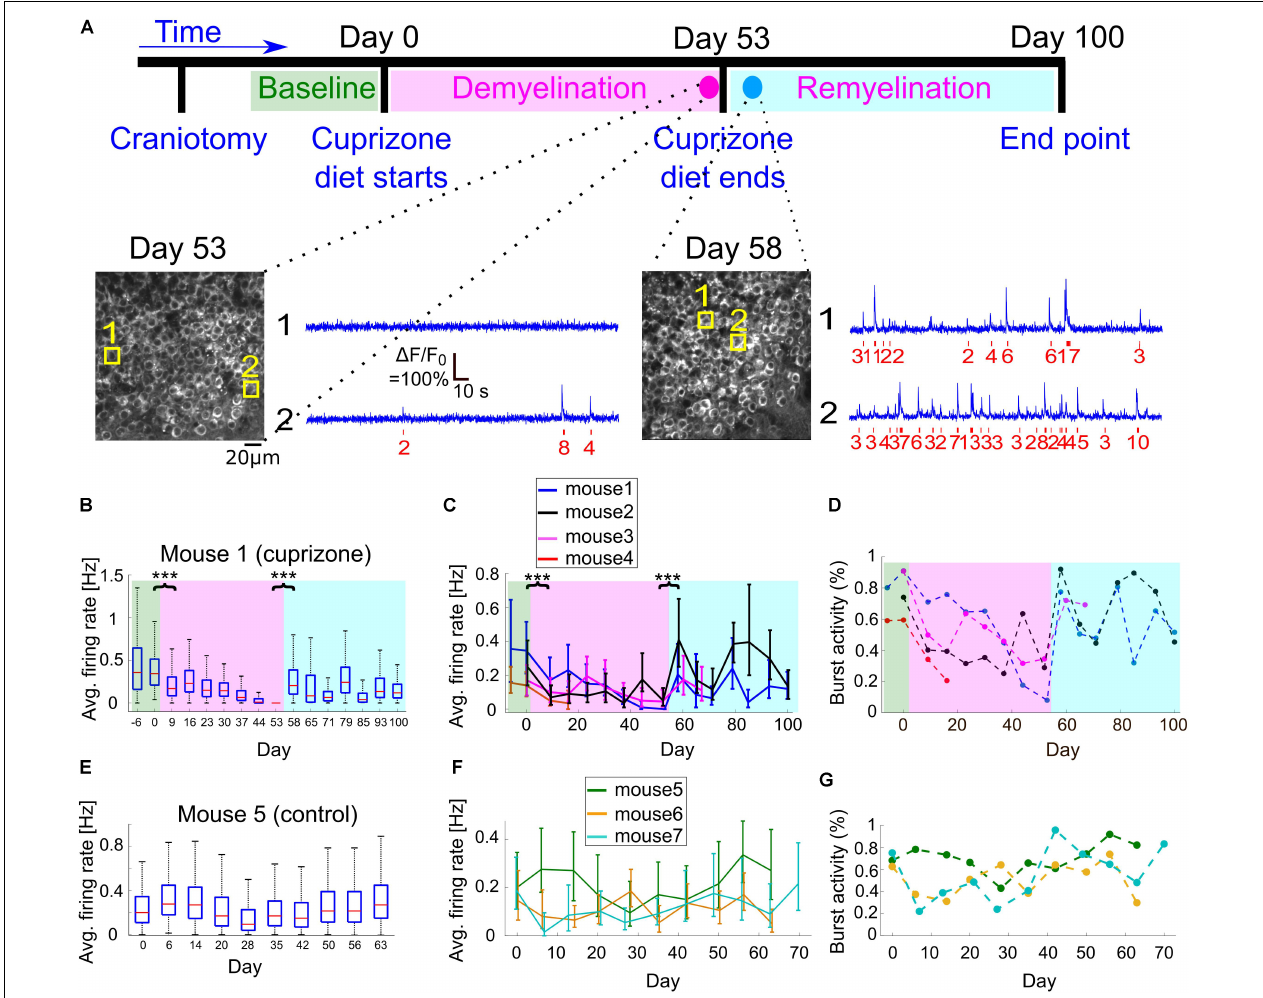
FIGURE 3 | Changes to CA1 activity patterns during demyelination and remyelination. (A) Time line of the demyelination/remyelination experiment for mice 1–4. Craniotomy surgery was performed between day-14 and -7, and baseline activity recording from CA1 and DG neurons started between day -6 and day 0 [indicated by green background in panels (B–D) ]. On day 0, after an activity recording session, we switched the diet to include 0.3% cuprizone. This diet was administered until day 53 [demyelination period, indicated by magenta background in panels (B–D) ], while we maintained weekly activity recordings. On day 53, after an activity recording was completed, we switched the mice back to normal diet and monitored activity until day 100 [remyelination period, indicated by cyan background in panels (B–D) ]. Bottom, two example fields of view acquired from mouse 1 (cuprizone group) showing the CA1 layer and activity of two CA1 example cells on days 53 and 58. The estimated timing and number of APs is shown (red) beneath each raw data trace (blue). (B) Summary of the average firing rates from all recorded CA1 neurons from mouse 1 during 107 days of recording. Firing rates decreased significantly from 0.345 to 0.17 Hz between day 0 and 9 ( P = 1.8 × 10 − 37 , Wilcoxon Rank Sum Test), after cuprizone diet had been introduced. Activity levels continued to significantly decrease down to zero on day 53 ( P = 0.002, Mann-Kendall Trend Test), and were significantly increased to 0.205 Hz on day 58, 5 days after normal diet was resumed ( P = 4 × 10 − 133 , Wilcoxon Rank Sum Test). Activity levels on the following days continued to increase compared to the demyelination period ( P = 0.064, Mann-Kendall Trend Test), but remained lower than the pre-cuprizone period. Magenta and cyan backgrounds highlight the demyelination and remyelination periods, respectively; red lines correspond to medians, blue boxes show the 25th–75th percentile range, whisker length is the shorter of 1.5 times the 25th–75th range or the extreme data point. Outliers are not shown. ∗∗∗ P < 0.001. (C) Summary of the average firing rates from all recorded CA1 neurons from all cuprizone-treated mice. Solid lines connect the distribution medians, and the error bars indicate the 25th–75th percentile range for each recording session. For all recorded mice, there was a significant decrease in the average firing rate upon the start of cuprizone diet, between day 0 and 9 ( n = 4 mice, P < 10 − 13 , Wilcoxon Rank Sum Test), and a significant increase upon the termination of cuprizone diet, between day 53 and 58 ( n = 3 mice, P < 10 − 32 , Wilcoxon Rank Sum Test). Note that the rapid increase in firing rate on day 58 was followed by a second decrease in activity rate. ∗∗∗ P < 0.001. (D) Summary of the fraction of cells that fired bursts of APs from all recorded cells for all cuprizone-treated mice. This fraction decreased for all mice during the demyelination period and rapidly recovered upon the start of the remyelination period. Colors are the same as in panel (C) . P -values for the decrease were 0.035, 0.108, and 0.064 for mice 1, 2, 3, respectively (Mann-Kendall Trend Test). (E) Summary of the average firing rates from all recorded CA1 neurons from control mouse 5, which received normal diet throughout the recording period, showing no similar decreases or increases in firing rate as those recorded from cuprizone-treated mice. (F) Summary of the average firing rates from all recorded CA1 neurons from all control mice. Solid lines connect the distribution medians, and the error bars indicate the 25th–75th percentile range for each recording session. None of the traces showed a significant monotonous trend ( P = 0.99, 0.86, 0.14, for mice 5, 6, 7, respectively, Mann-Kendall Trend Test). (G) Summary of the fraction of cells that fired bursts of APs from all CA1-recorded neurons from all control mice. Colors are the same as in panel (F)